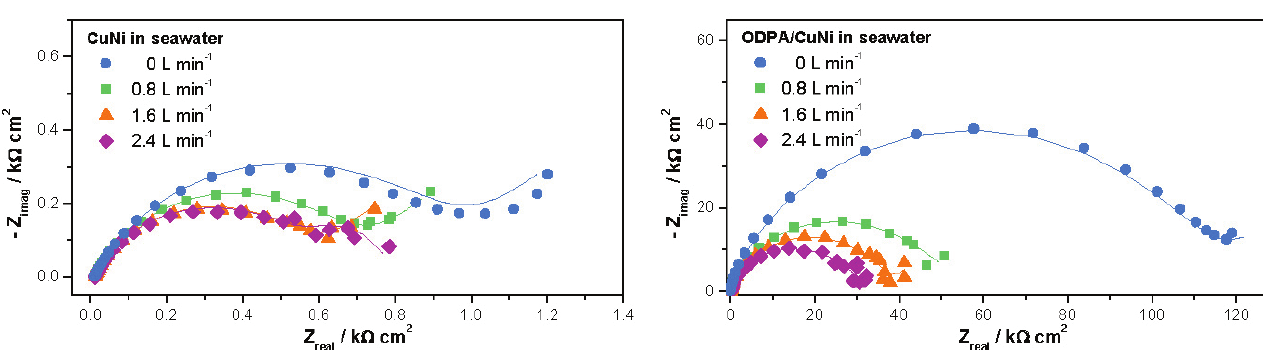
Fig. 5 – Nyquist plots of EIS spectra for blank and ODPA-treated CuNi alloy in different seawater flow rates. Dots represent exper- imental data, and lines represent the fitted data obtained by fitting the spectra to models given in Fig. 6.